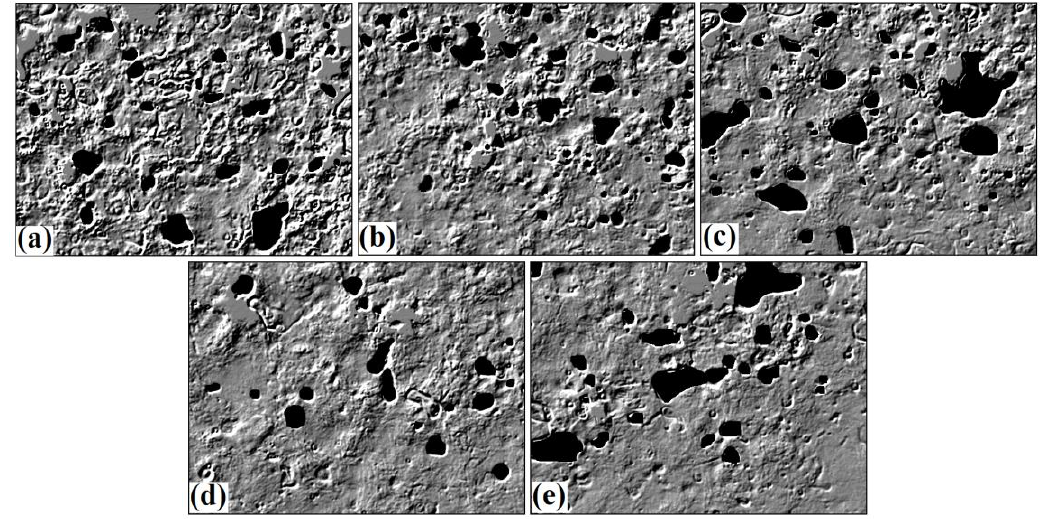
Figure 4. Segmented regions of water in the dough samples ( a ) MT1, ( b ) MT3, ( c ) MT5, ( d ) MT7.5, and ( e ) MT10.